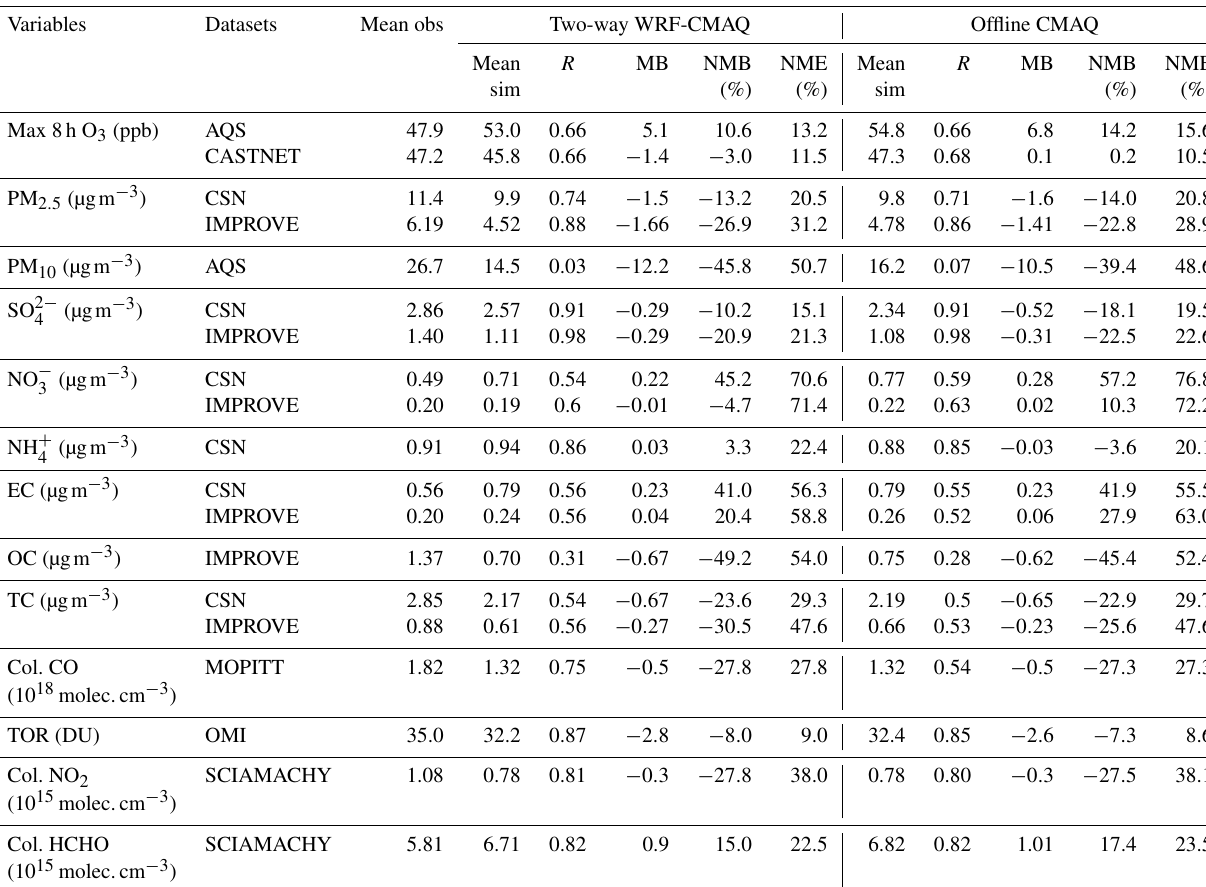
Table 4. The 5-year average performance statistics for chemical variables between two-way WRF-CMAQ and offline CMAQ simulations in summer 2008–2012.